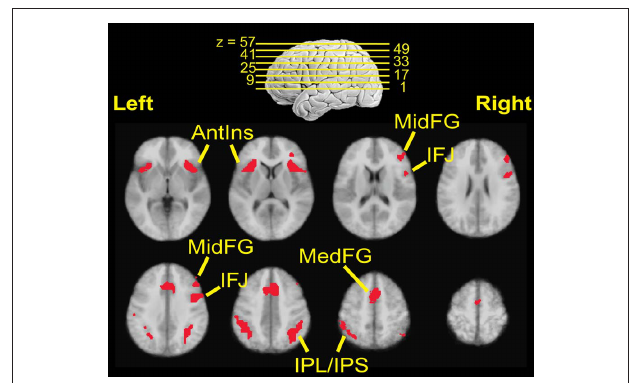
Figure 5 | regions of interest locations. Locations are defined from observations of a significant difference in fMRI signal between indicated and contraindicated targets in the 80/20 prior knowledge condition.